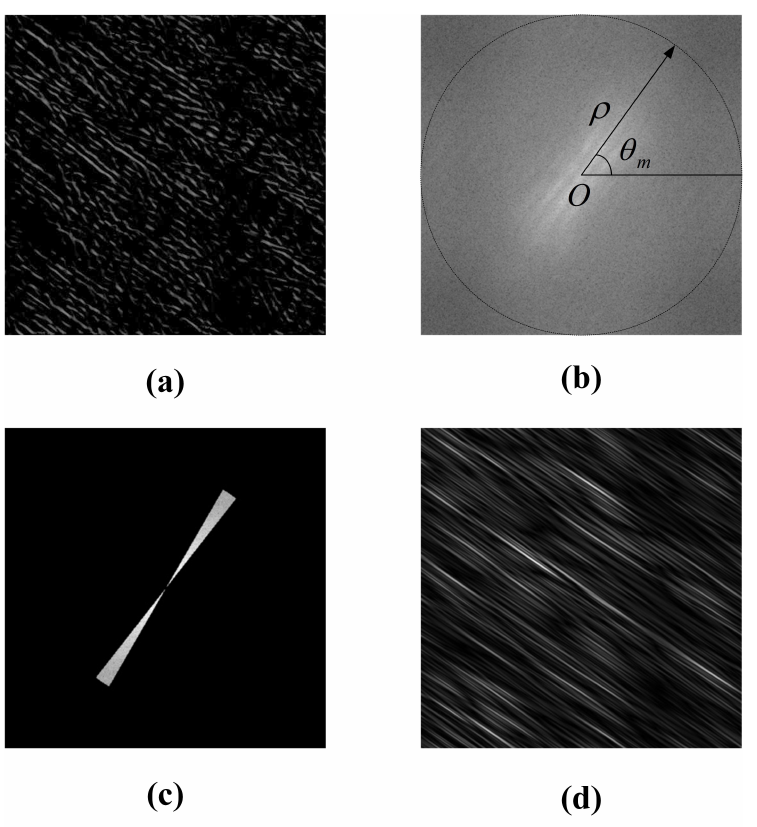
Figure 5. The process of denoising. ( a ) The enhanced STI. ( b ) The polar coordinate system of ( a ). ( c ) The Fan-type masking. ( d ) The denosied